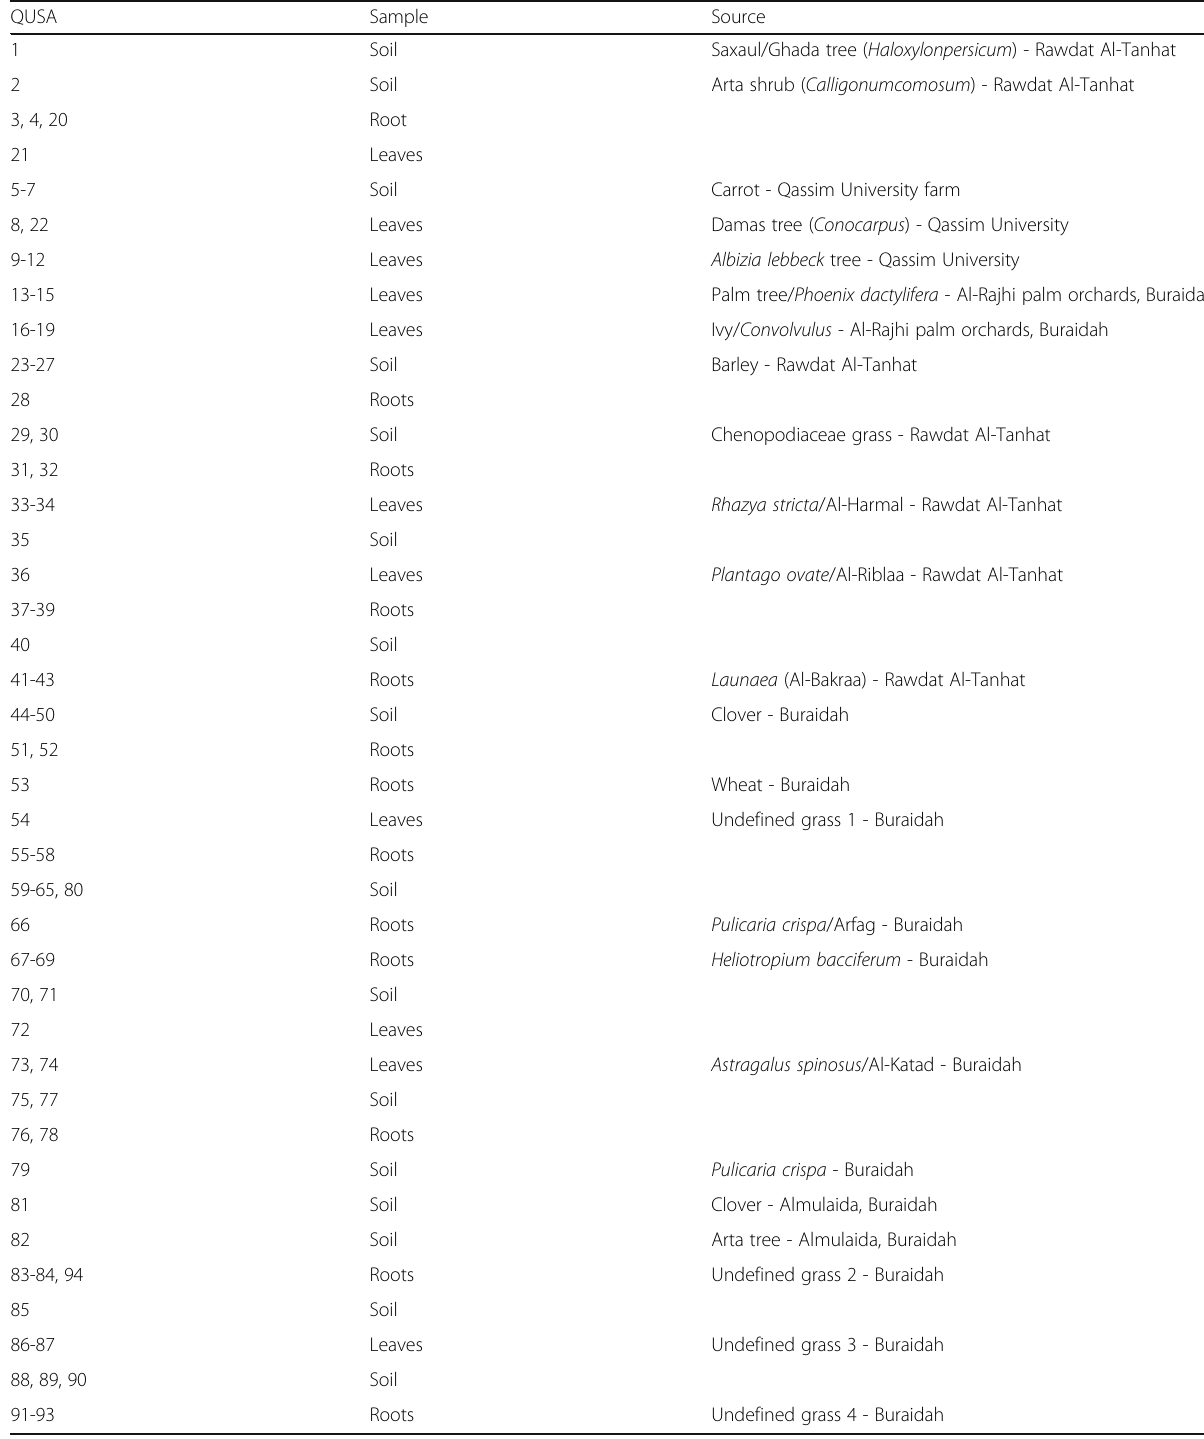
Table 1 Sources and locations of bacterial isolates were collected from Qassim region in Saudi Arabia/QUSA